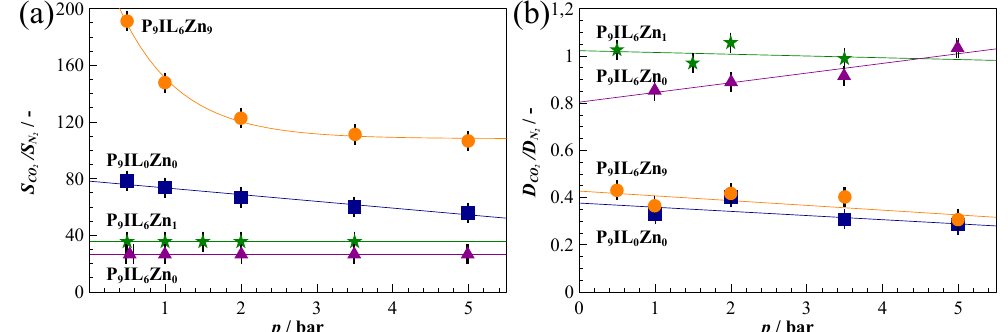
Figure 4. CO 2 /N 2 ideal solubility ( a ) and diffusivity ( b ) selectivities derived from single gas sorption experiments at 20 ◦ C. The solid curves provide guides for